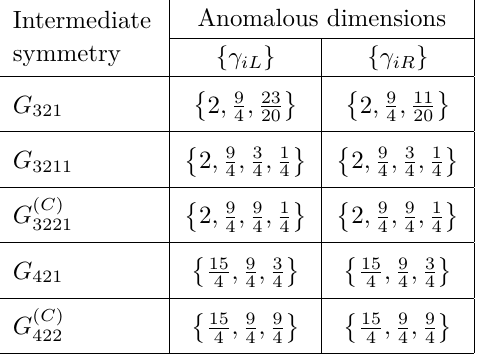
Table 4 . Anomalous dimensions for intermediate symmetries of SO(10) breaking to G 321